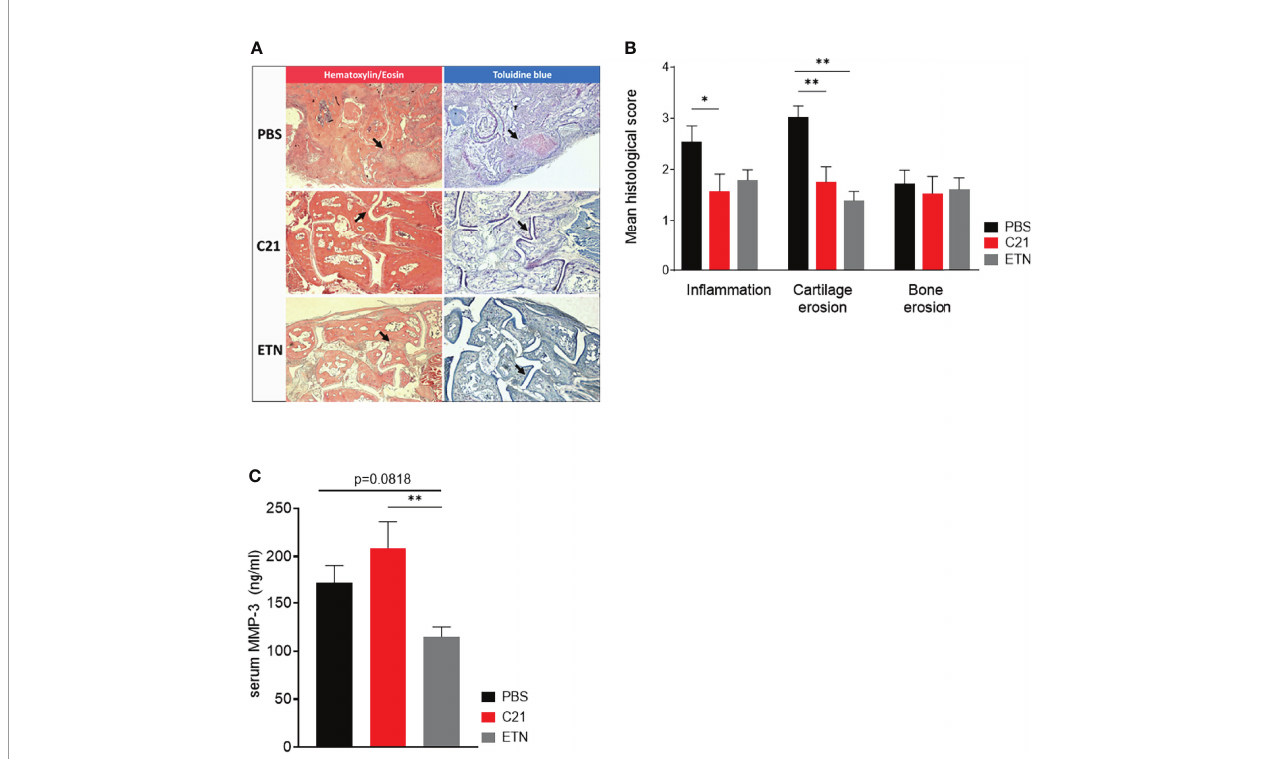
FIGURE 2 | C21 treatment reduces in fl ammation and cartilage erosions, but did not alter serum MMP-3 concentrations. (A) Paraf fi n-embedded sections were stained with hematoxylin/eosin (HE), toluidine blue (TB) and tartrate-resistant acid phosphate (TRAP). Representative histopathological images of the early therapeutic C21 treatment are shown. HE (left column) and TB-stained (right column) hind paw sections of CII-immunised mice at day 47 upon PBS (upper row), C21 (middle row) and ETN treatment (lower row) are shown. Areas of in fl ammatory in fi ltrates (Panel A, left column ) and cartilage damage (Panel A, right column ) are indicated by arrows. Original magni fi cation 5x. (B) The sections were evaluated for in fl ammation, cartilage erosions and bone erosions according to a graded scale from 0-3 and expressed as mean histological score. PBS (n=45), C21 (n=41), ETN (n=10). (C) Total MMP-3 concentrations were measured by ELISA in serum samples on day 47 of the early therapeutic approach. PBS (n=20), C21 (n=17), ETN (n=18). P*<0.05, P**<0.01. Values shown are the mean ± SEM. P-values were using the Kruskal-Wallis test followed by Dunn ’ s post hoc test for multiple